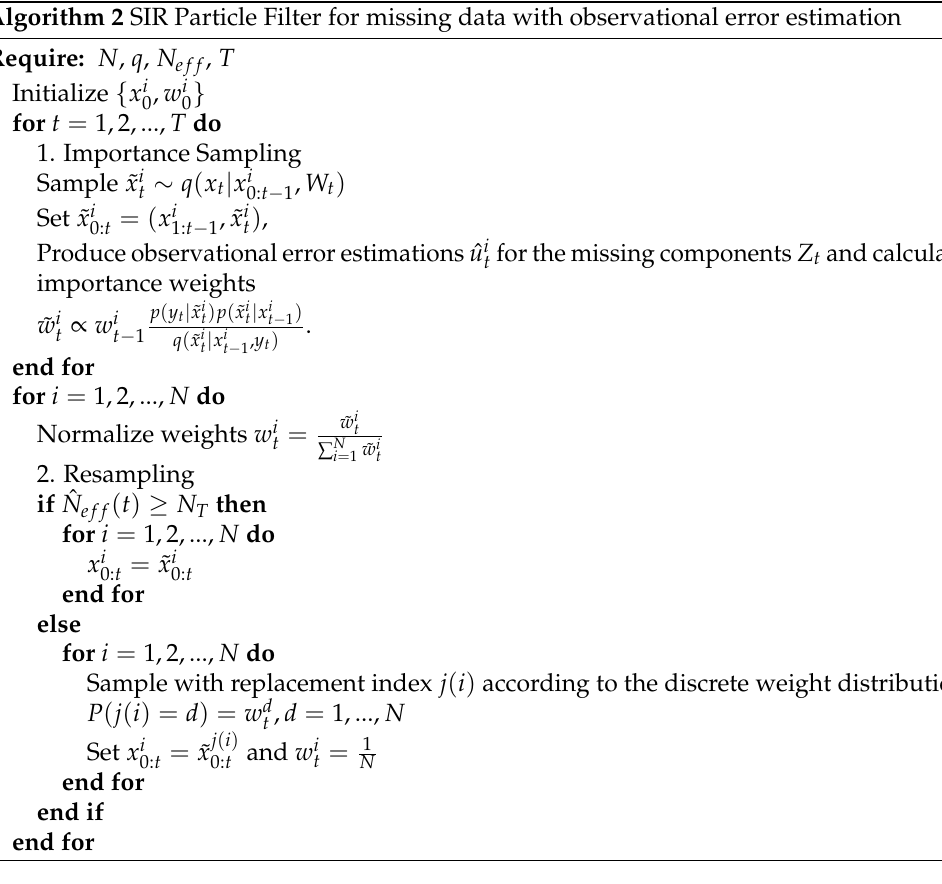
Algorithm 2 SIR Particle Filter for missing data with observational error